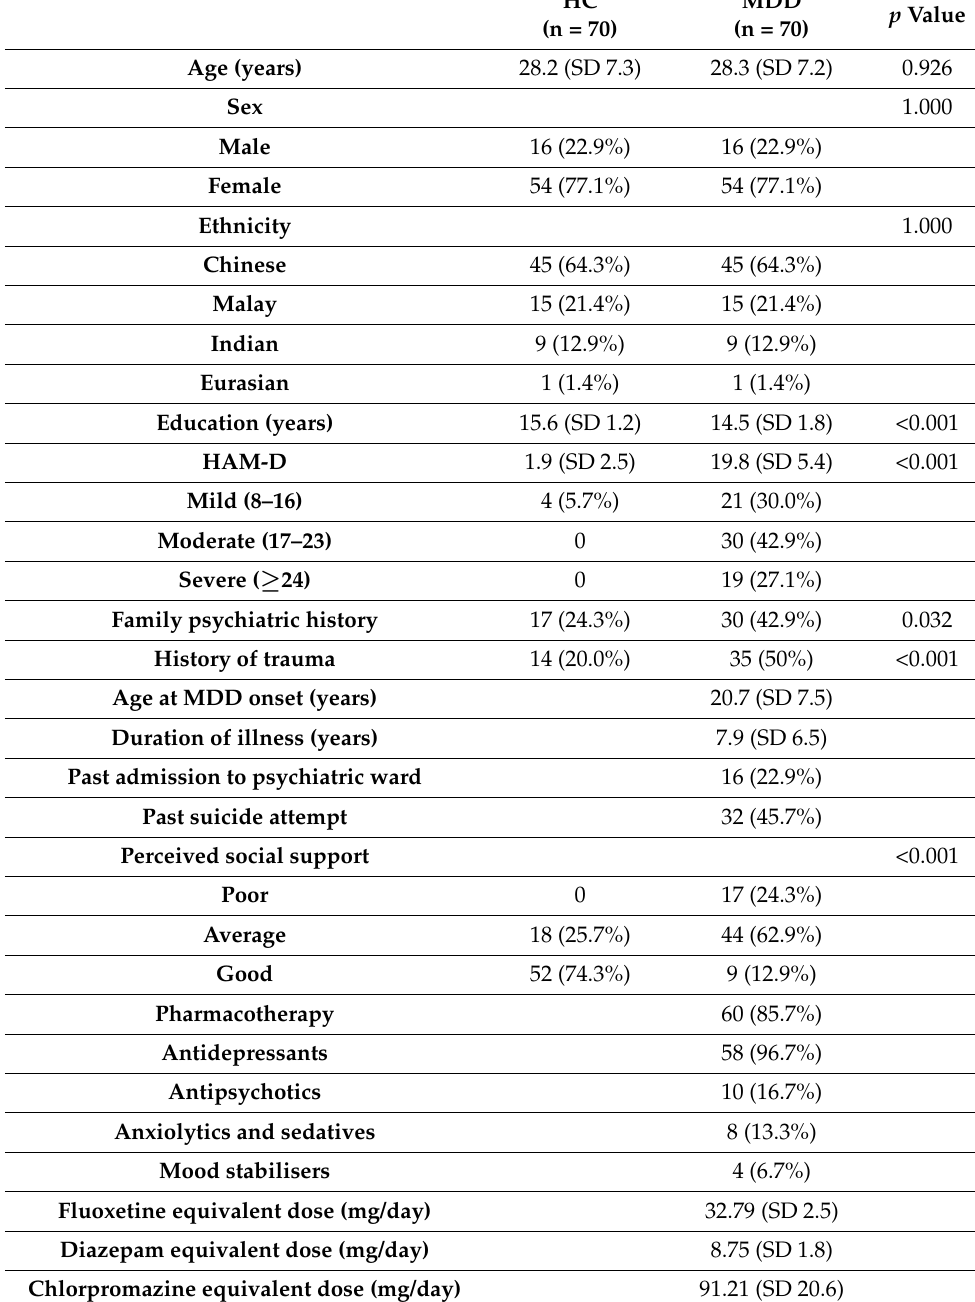
Table 1. Demographic and clinical characteristics of HCs and MDD